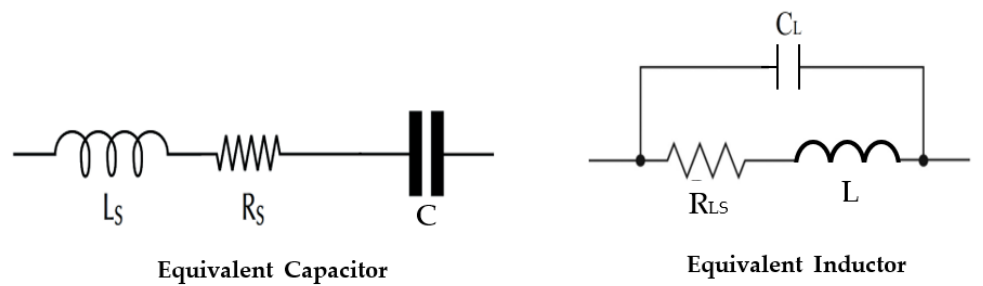
Figure 10. Equivalent circuit of capacitor and inductor. L s : Series inductance, R s : Electrodes and ter- minations resistance, C: Capacitance, L: Inductor, C L : Parasitic capacitor, R LS : Intern resistor.